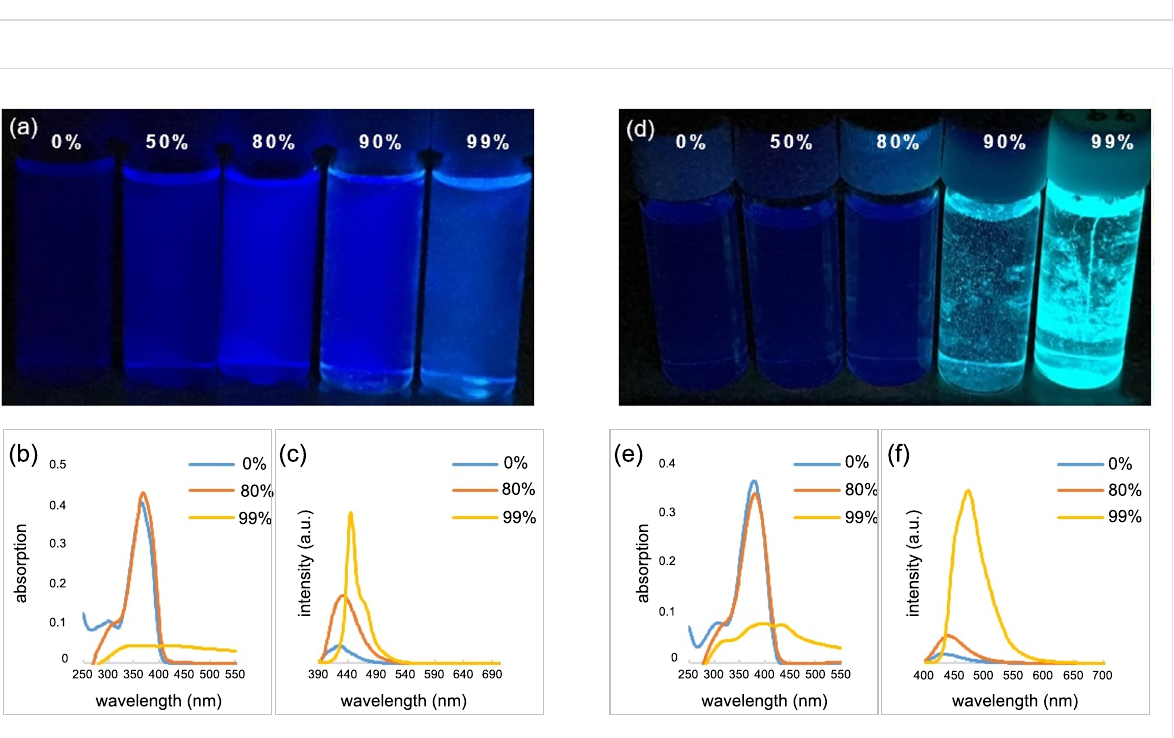
Figure 2: Photochemical properties comparisons of BKIs and F-BKIs. (a–c) BKI 6b : photograph (a), UV–vis (b), and FL (c) spectra at different sol- vent compositions of THF/H 2 O upon excitation at 365 nm (1.0 × 10 − 5 M); (d–f) F-BKI 9b : photograph (d), UV–vis (e), and FL (f) spectra at different solvent compositions of THF/H 2 O upon excitation at 380 nm (1.0 × 10 − 5